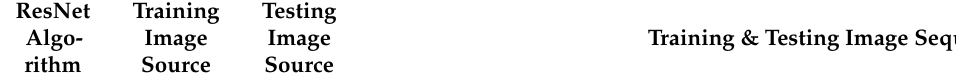
Table 4. Sub-analysis of accuracy and area under the receiver operating characteristic curve for models trained and tested on ProstateX-2, local institutional, and combined ProstateX-2 and local institutional image data using lesions from either the peripheral or transitional zones only, with 5-fold cross-validation. t -tests compared the AUC and accuracies of models trained and tested using the same image data source (labeled *) with those using different training and testing sources (labeled †); statistically significant differences are underlined ( p < 0.01). PX2: ProstateX-2 data, Local: local institutional data, PXL: combined prostateX-2 and local institutional